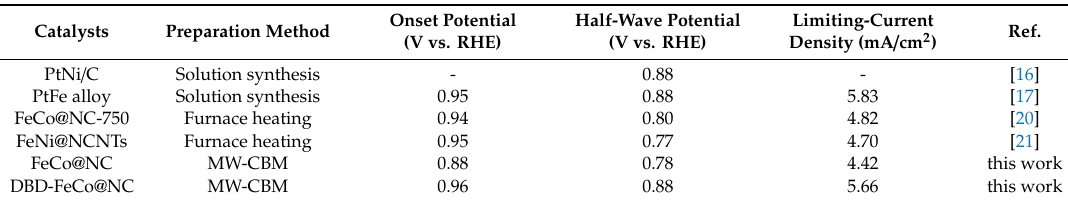
Figure 4. ( a ) Linear sweep voltammetry (LSV) curves of FeCo@NC, DBD-FeCo@NC, and 20 wt.% Pt/C in O 2 -saturated 0.1 M KOH, with a speed of 1600 rpm at a sweep rate of 10 mV/s; ( b ) cyclic voltammetry (CV) curves of DBD-FeCo@NC at a scan rate of 50 mV/s in N 2 -saturated or O 2 -saturated 0.1 M KOH electrolyte; ( c ) LSVs of DBD-FeCo@NC at various rotation speeds and corresponding K–L plots ( d ); ( e ) long-term stability tests; and ( f ) tolerance to alcohol poisoning tests of DBD-FeCo@NC and 20 wt.% Pt/C via the oxygen reduction reaction (ORR) cathodic current-time ( i - t ) method. Table 2. FeCo@NC and DBD-FeCo@NC compared with other alloy catalysts. Reversible hydrogen electrode (RHE); microwave-assisted carbon bath method (MW-CBM).